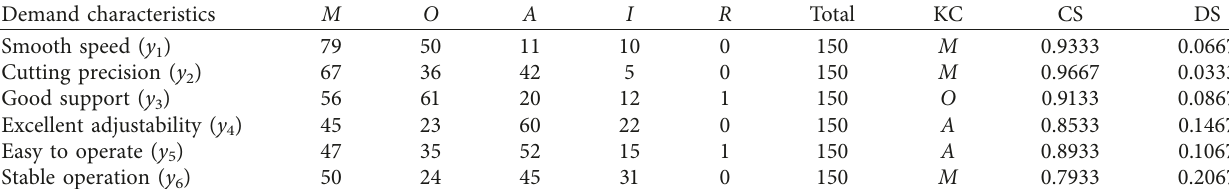
Table 3: Analysis of questionnaire results.